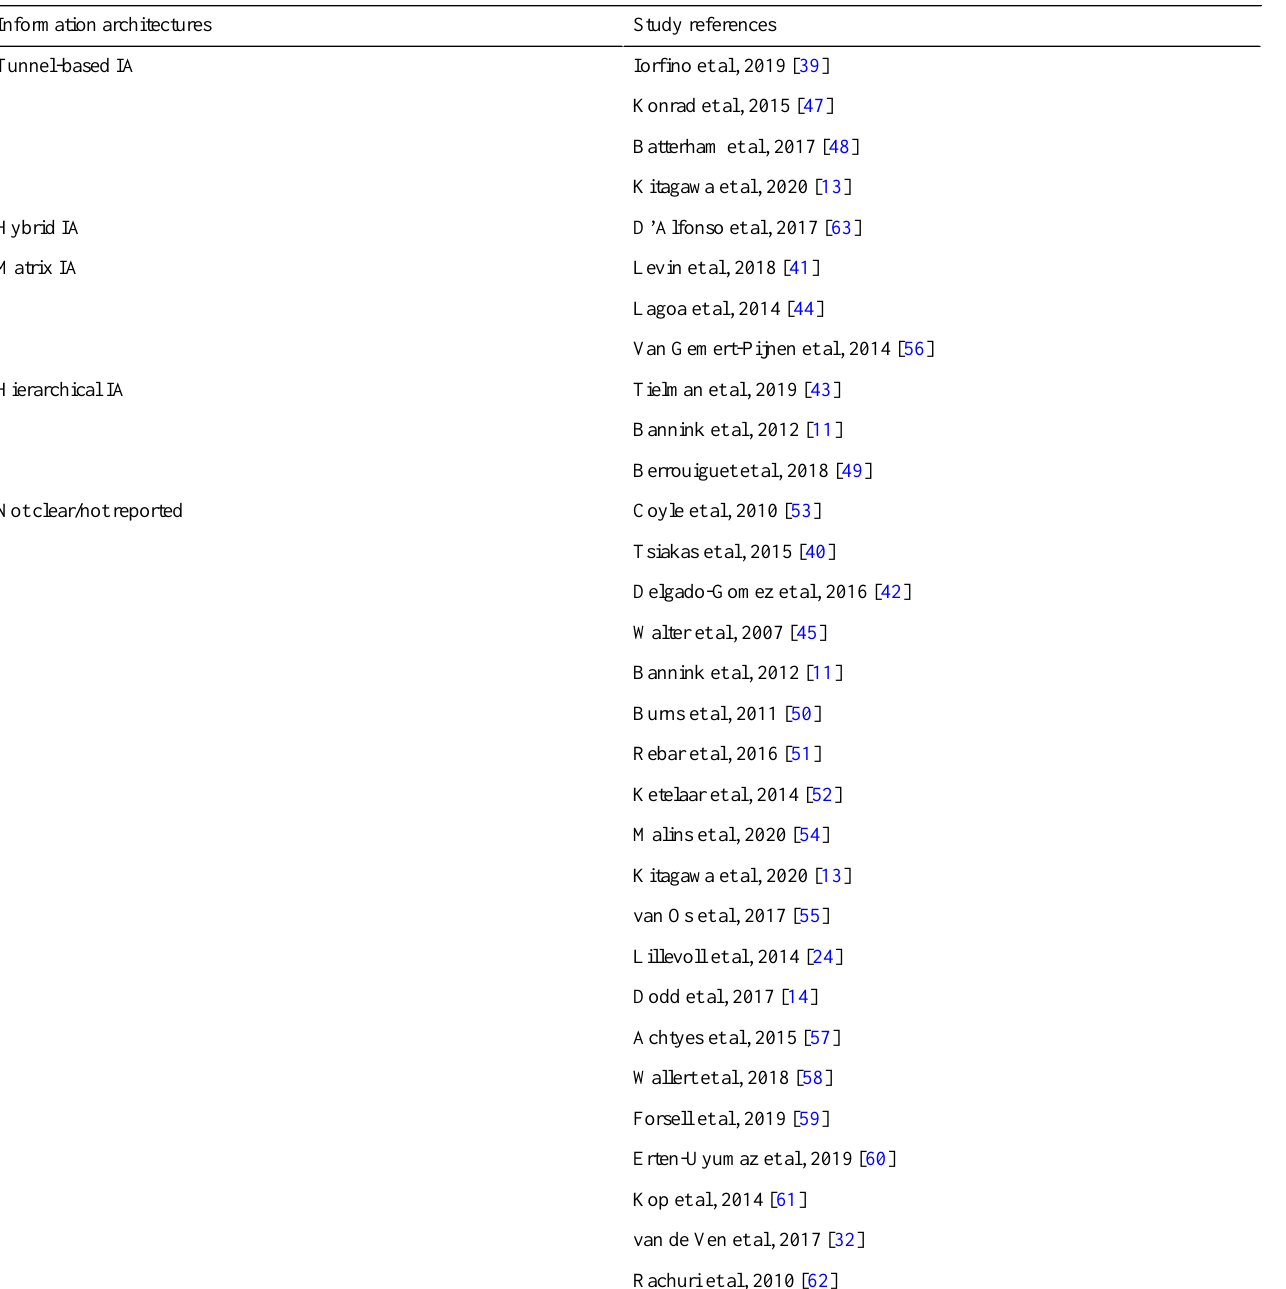
Table 2. Types of information architecture used in the reviewed